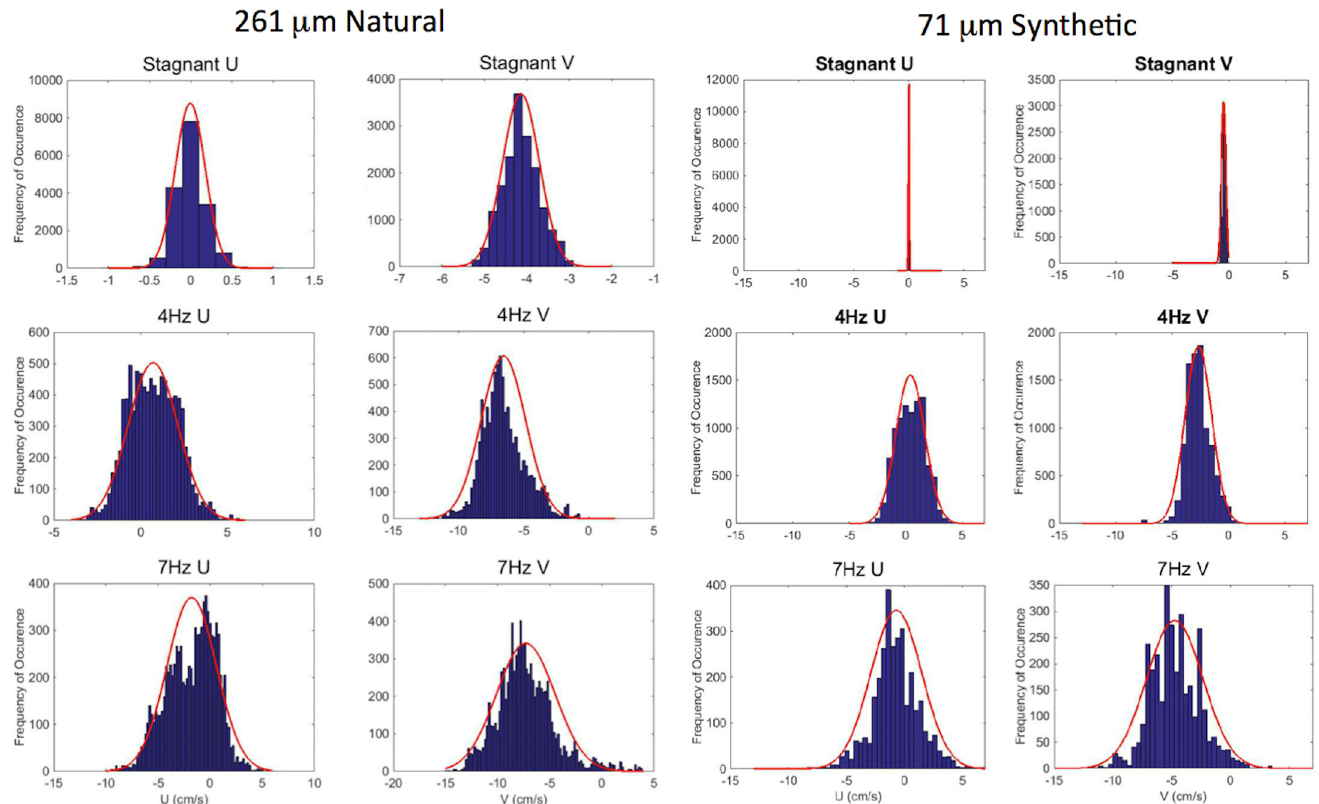
Fig 7. Histograms of the particles ’ u and v velocities in stagnant water and turbulent conditions (see subtitles) for (left) the 261 μ m natural sand and (right) the 71 μ m synthetic